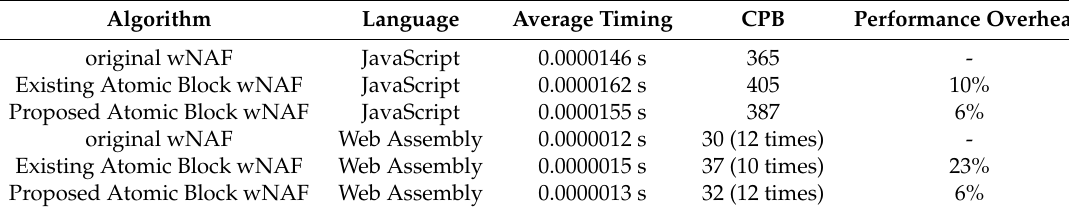
Table 14. wNAF algorithm performance in Firefox ( CPB : Cycle Per Byte), ( w = 4).